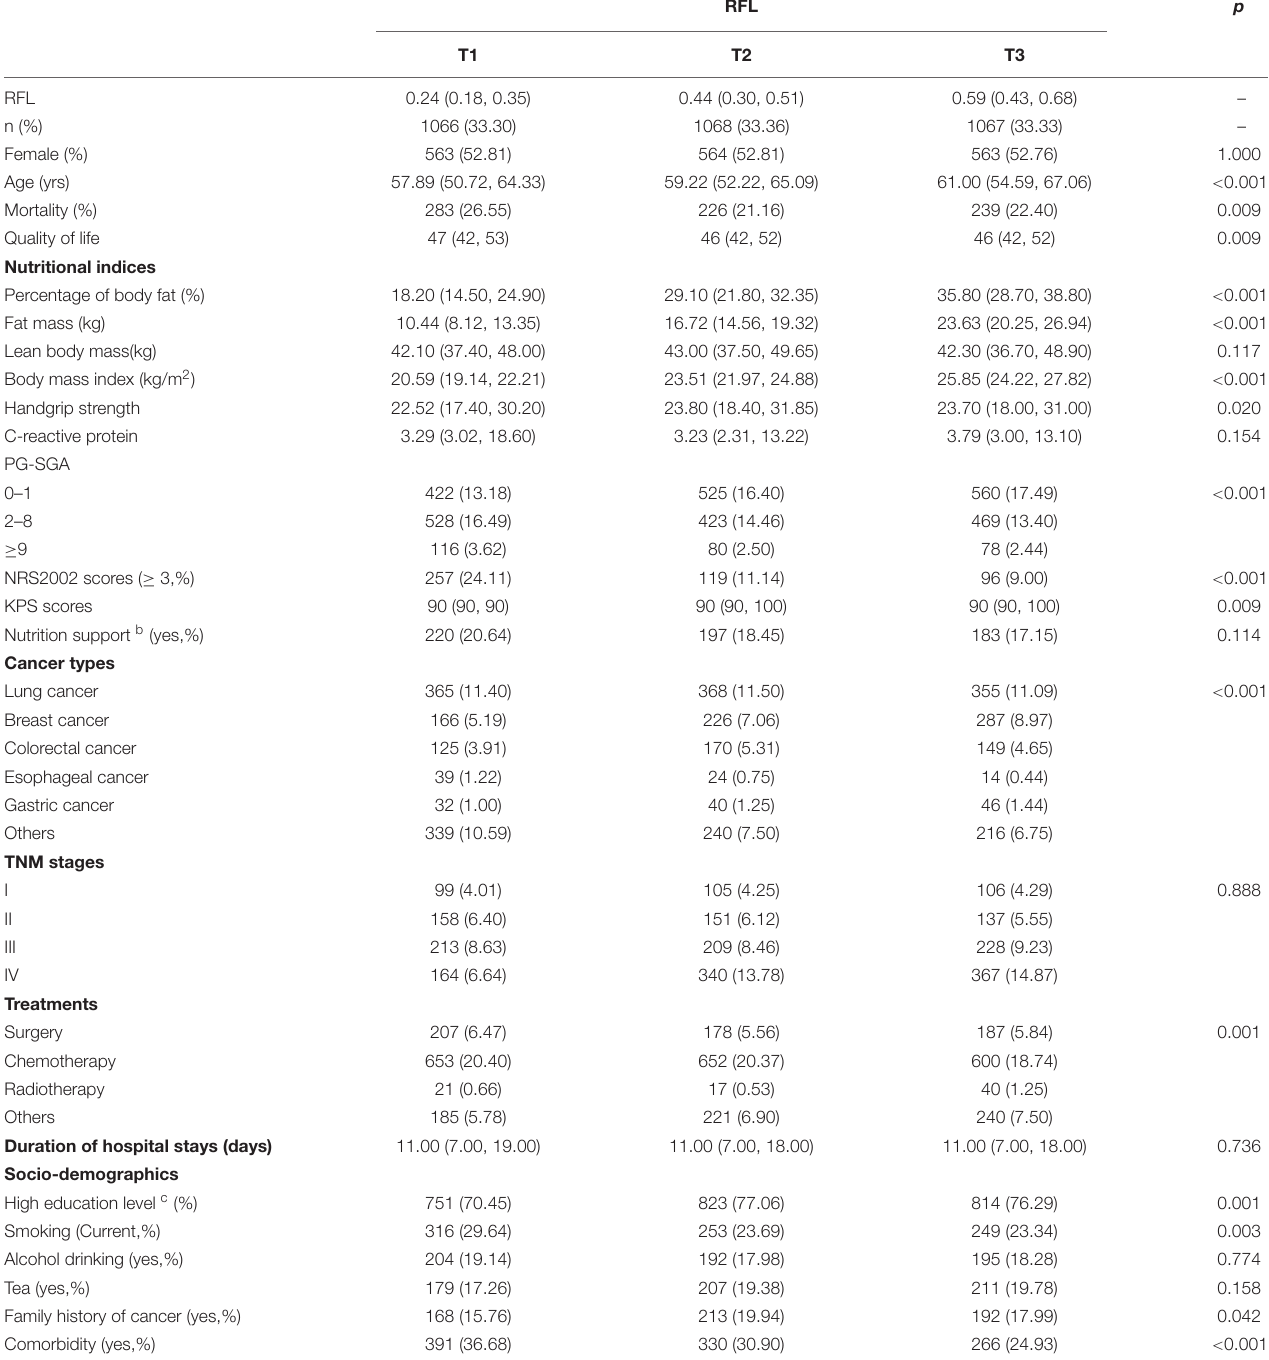
TABLE 1 | Characteristics a of participants stratified by tertile of fat mass to lean body mass